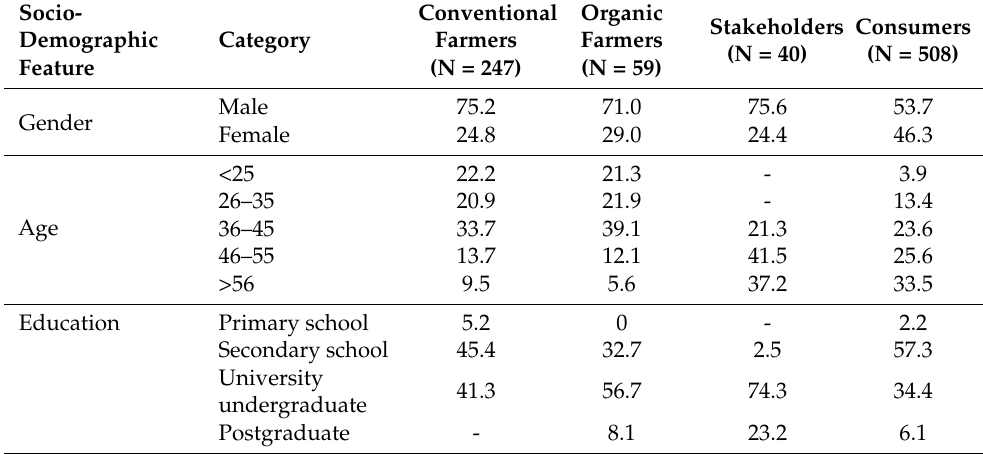
Table 1. Percentage of respondents per socio-demographic category for each category of respondent.